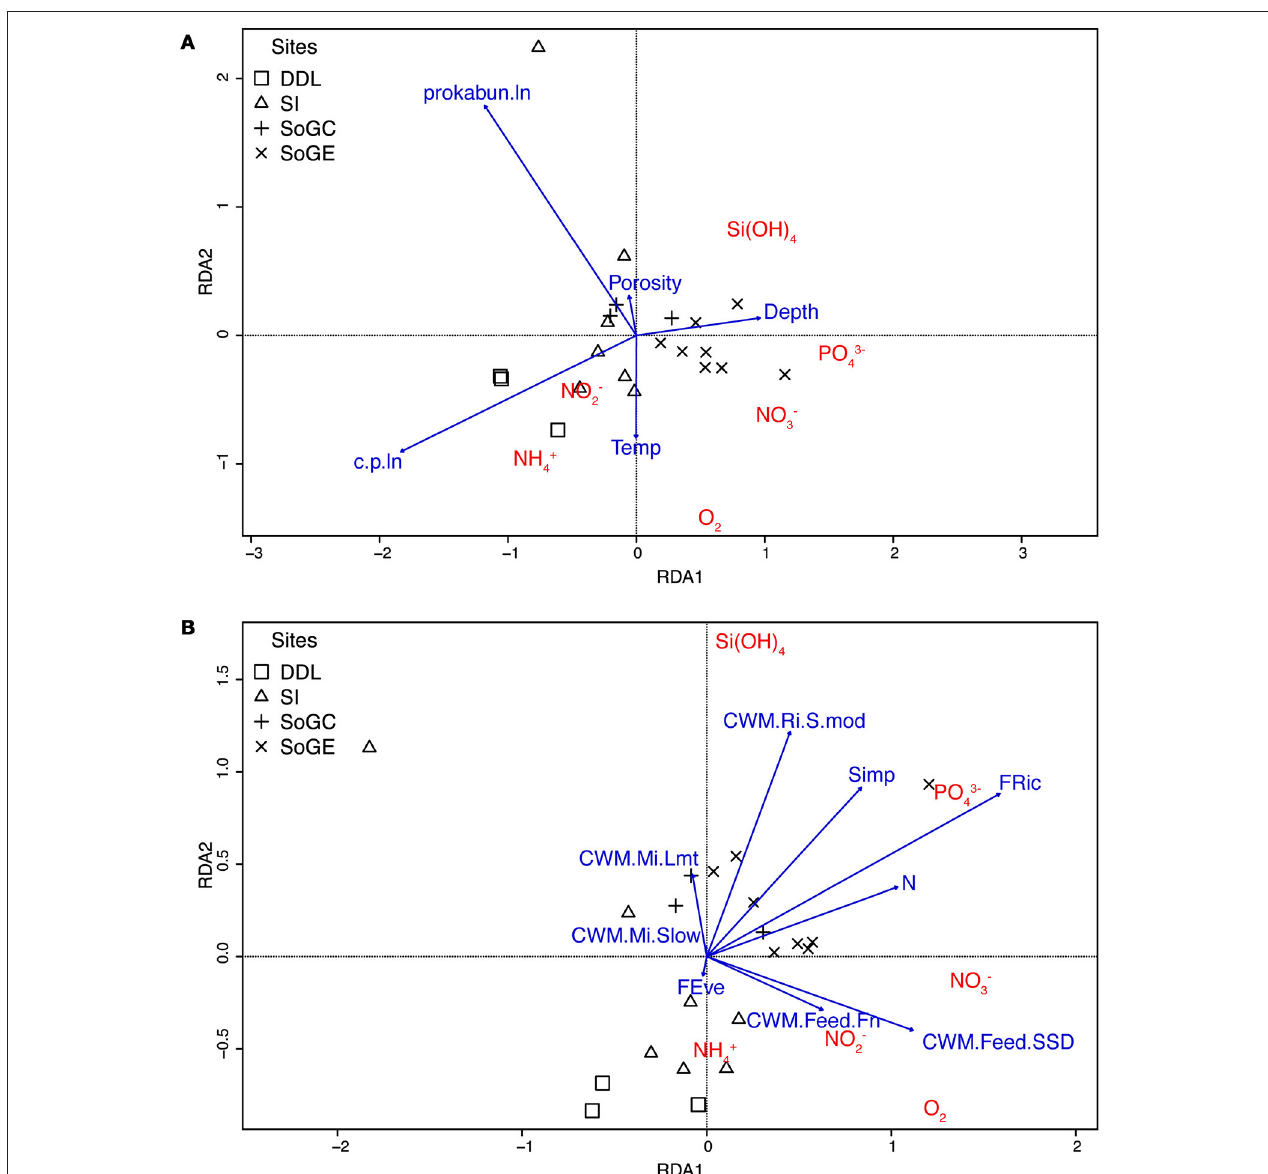
FIGURE 3 | Plot of the redundancy analysis (RDA) models of (A) environmental variables, and (B) functional diversity indices best explaining variation in Salish Sea benthic fluxes measured in May/July 2011, and September 2013.